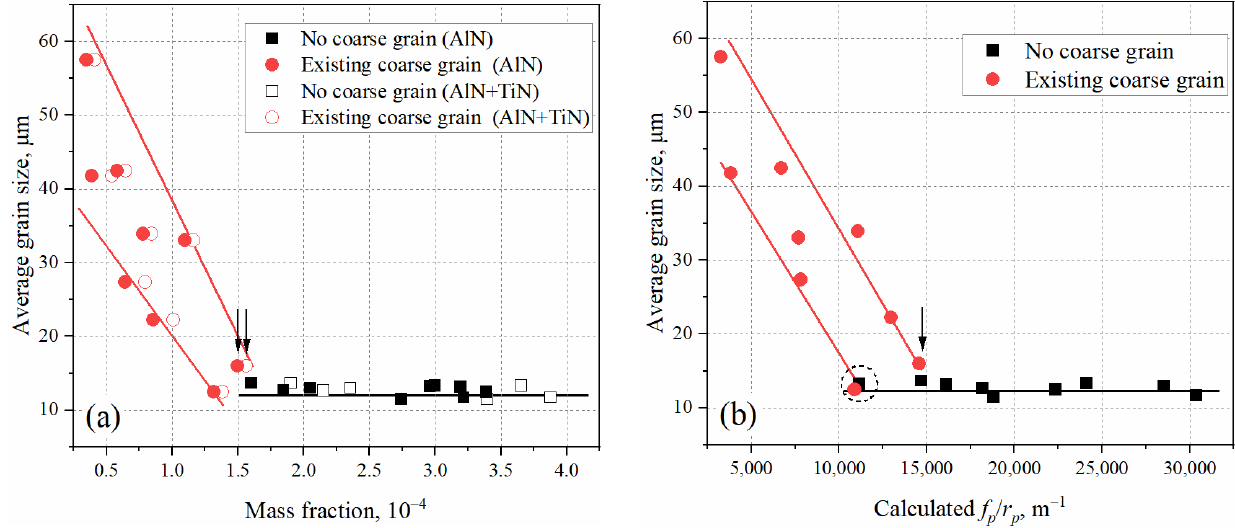
Figure 7. Relationships between the PAGS feature after carburization and the equilibrium mass fraction of precipitation ( a ) and the pinning strength f p / r p ( b ). In image ( b ), the circled dot corresponds to the case of S3 carburizing at 1019 °C.